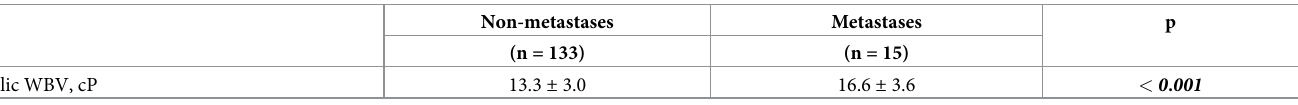
Data are given as n (%) or mean ± SD. HCC, hepatocellular carcinoma; HBV, hepatitis B virus; HCV, hepatitis C virus; NASH, non-alcoholic steatohepatitis; TB, total bilirubin; INR, international normalized ratio; AFP, alpha-fetoprotein; PIVKA-II, proteins induced by vitamin K antagonist-II; PVTT, portal vein tumor thrombosis; mUICC, modified international union against cancer; WBV, whole blood viscosity.